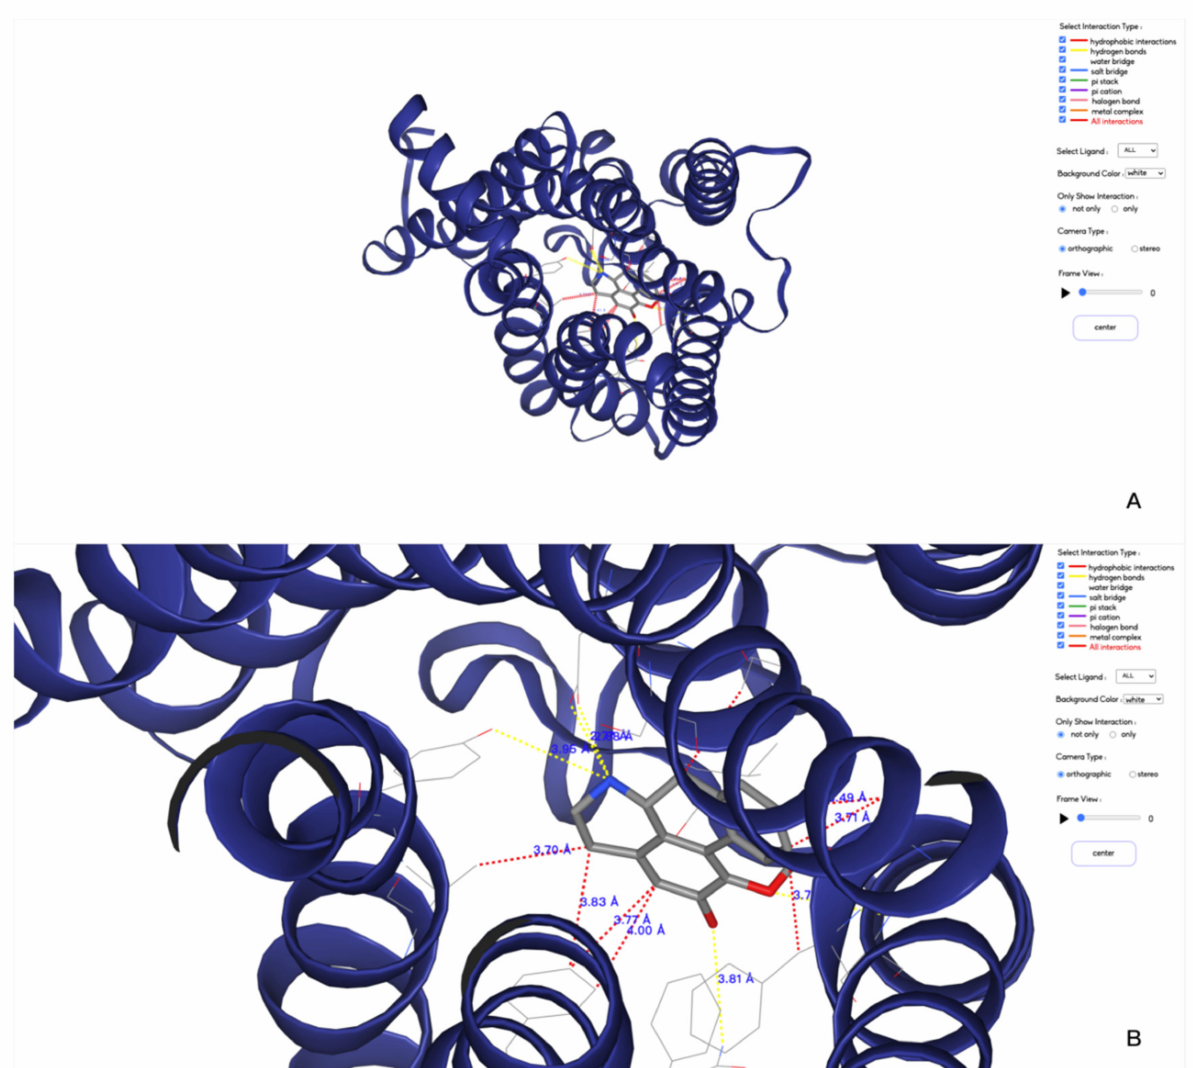
Figure 4. 3D visualizations of protein–ligand interactions between protein A2AR and ligand UNK. ( A , B ) are a default view and a zoomed in view of the 3D displaying,